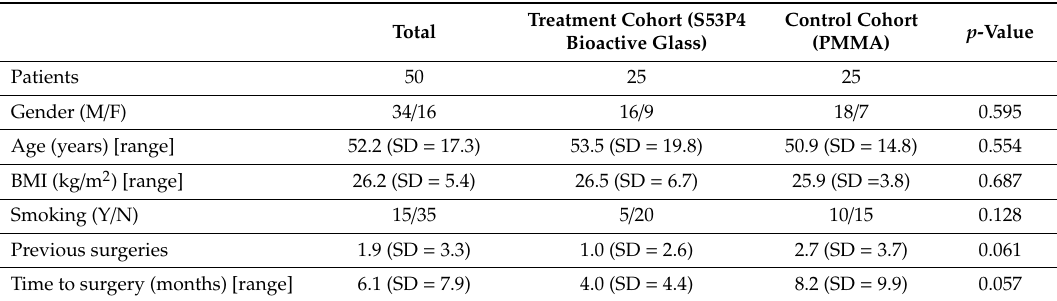
Table 1. Baseline characteristics of the total study population.